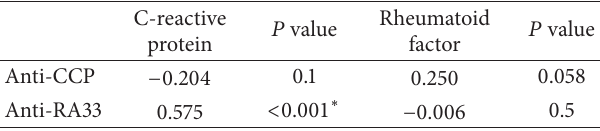
Table 5: Correlation of the diagnostic markers of RA with CRP and RF